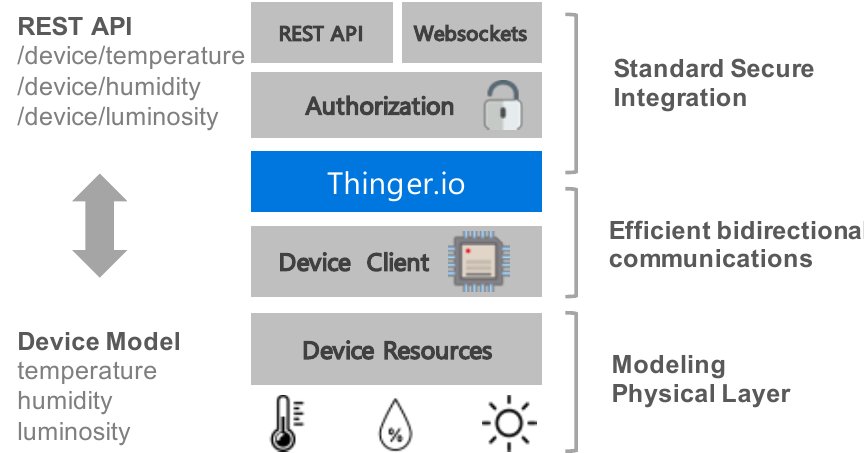
Figure 3. From the device model to REST API. Thinger.io allows device models to be defined that are automatically converted to REST APIs and can be consumed from any external application in real